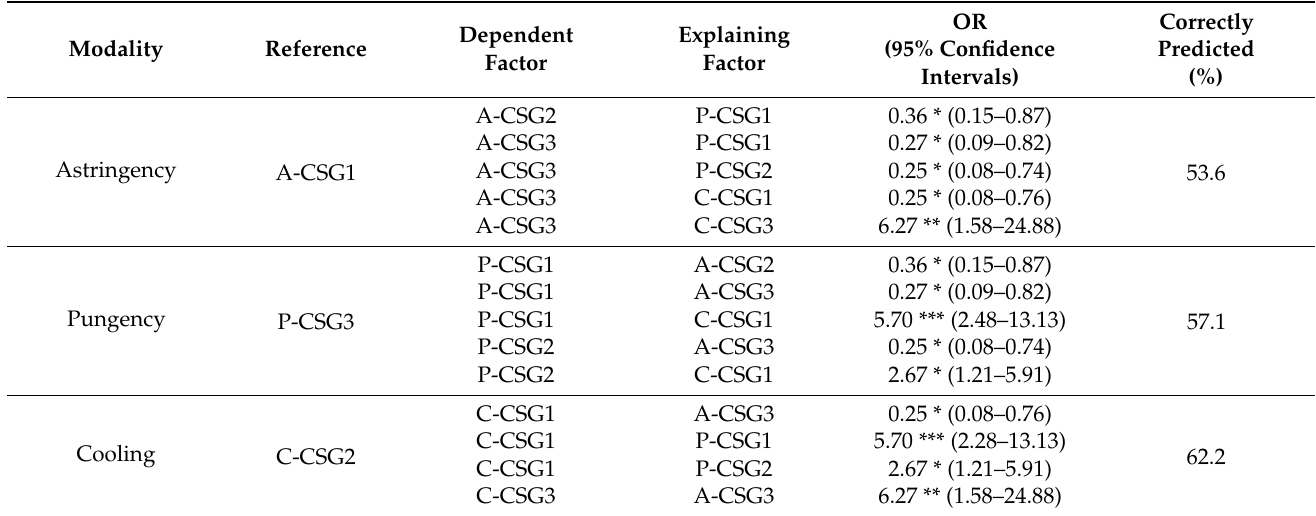
Table 4. The statistically significant odds ratios (OR) for chemesthetic interactions by the multinomial logistic regression model, N =